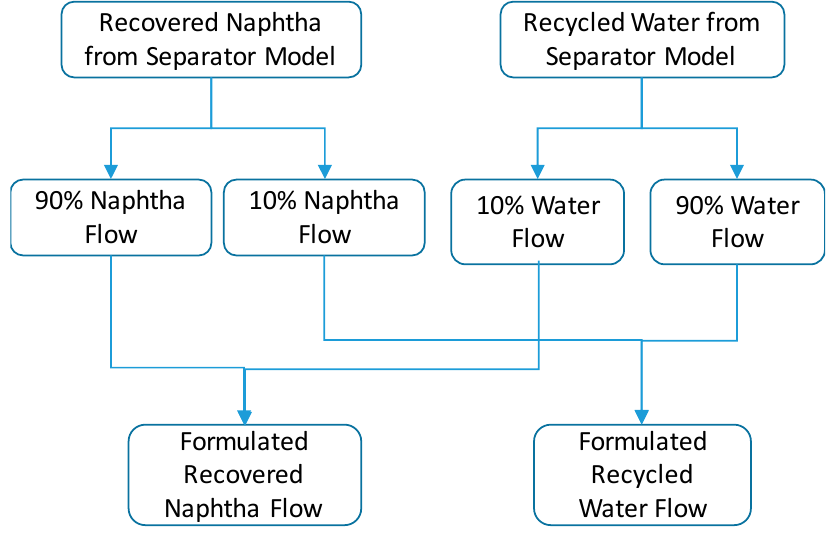
Figure 13. Illustration of “withdraw and remix” strategy to mimic the non-ideal NRU separators.